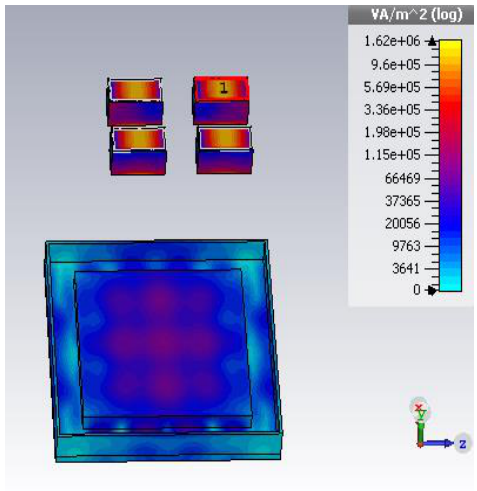
Fig. 2. The distribution of the power flow of a focused antenna array with four emitters.